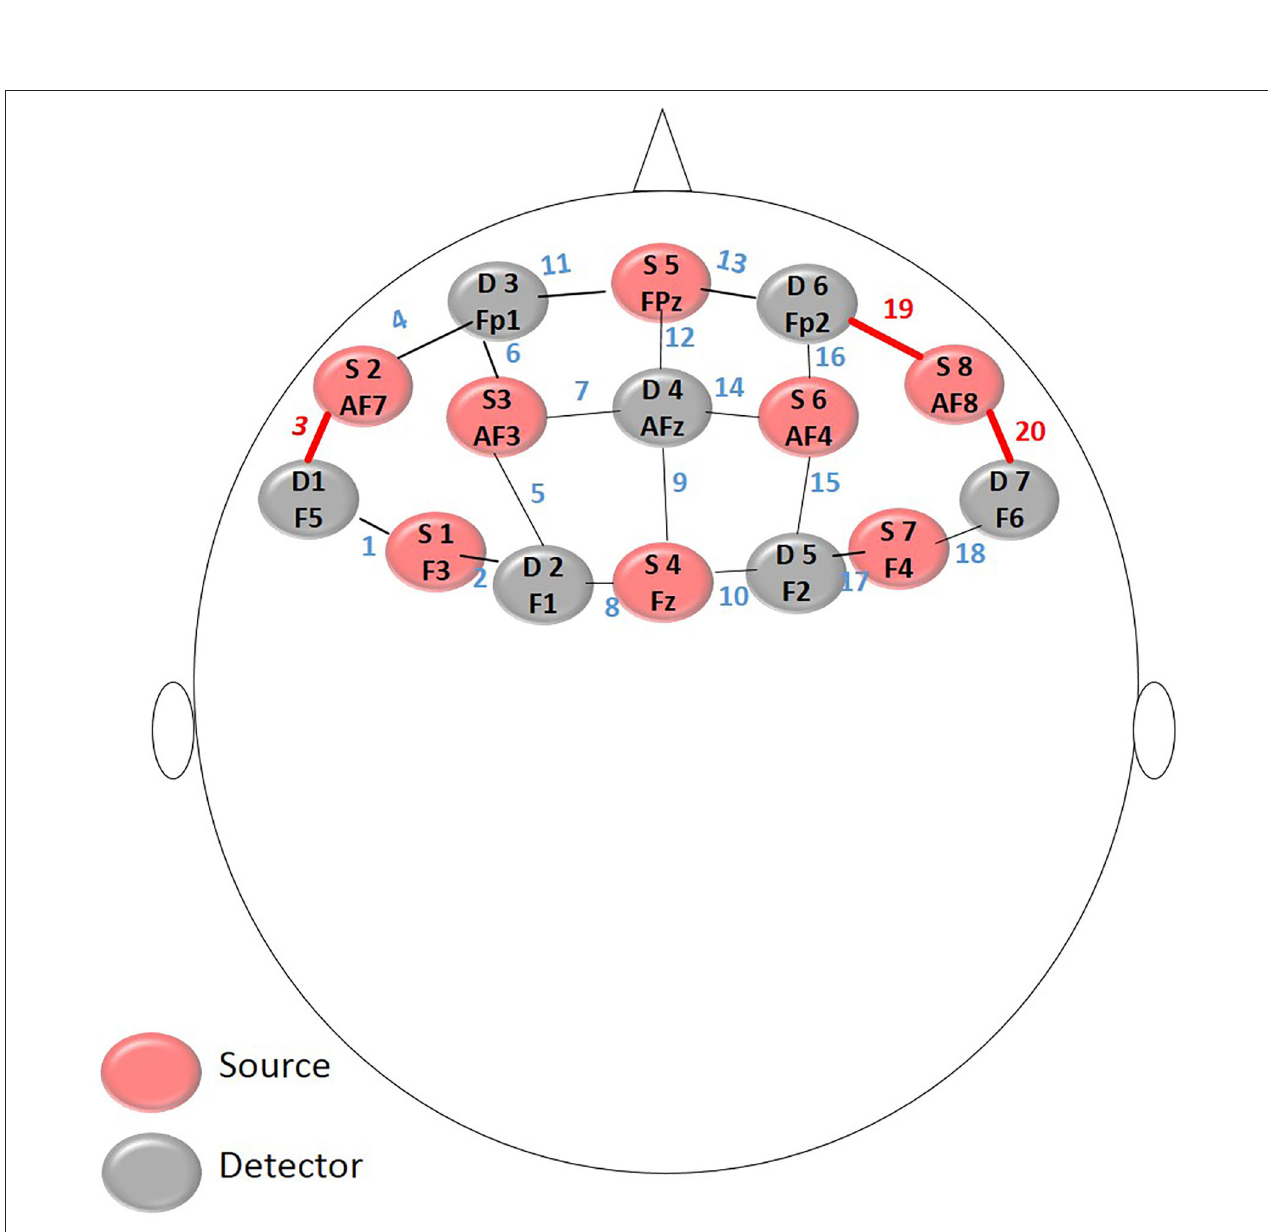
FIGURE 2 | Montage layout: The position of the optodes follows the universal configuration of the 10-10.